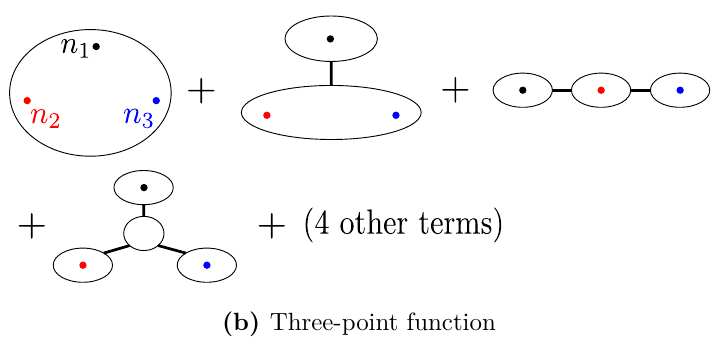
(cid:16) Q (cid:17) ˜ F . The result is given by a sum of prod- d n j j